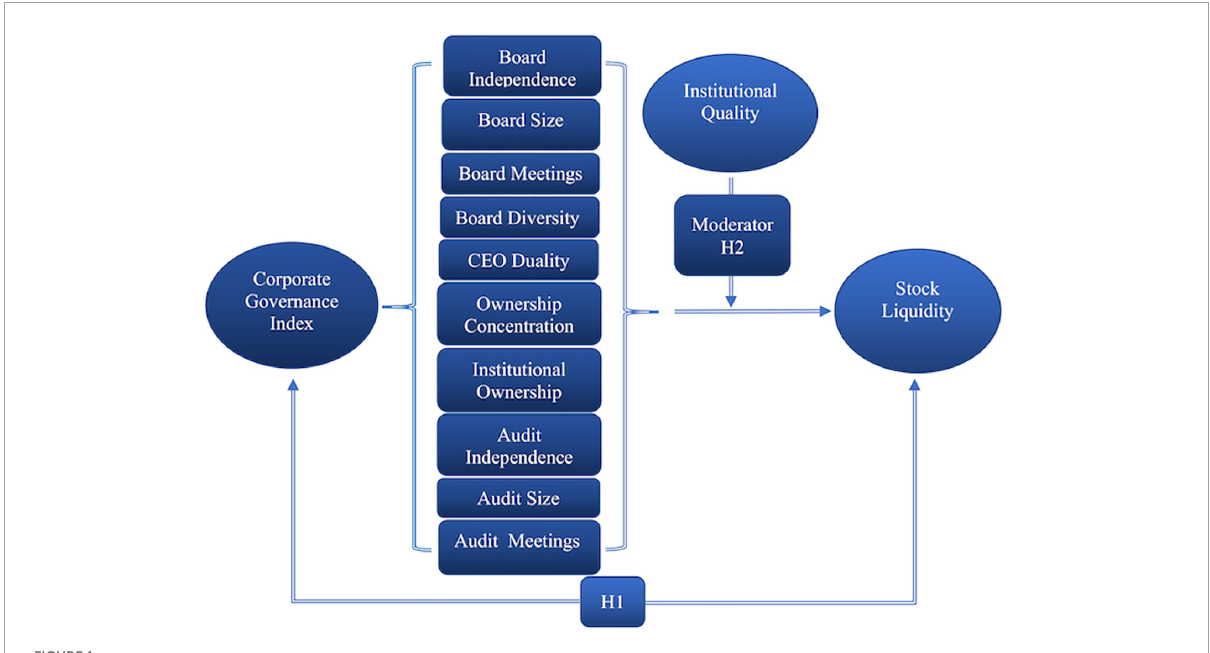
FIGURE1 Conceptual